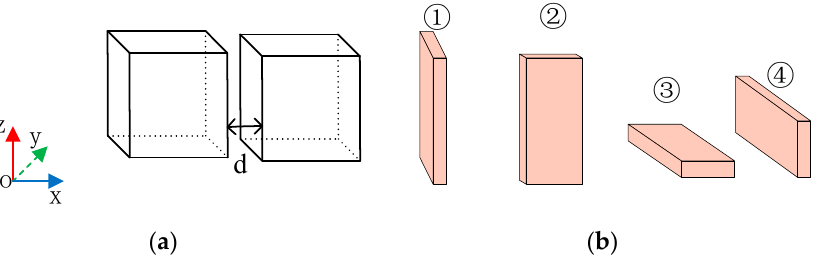
Figure 11. ( a ) A situation where two components are distributed horizontally; ( b ) Different ways of spreading through the bus between two components distributed horizontally.